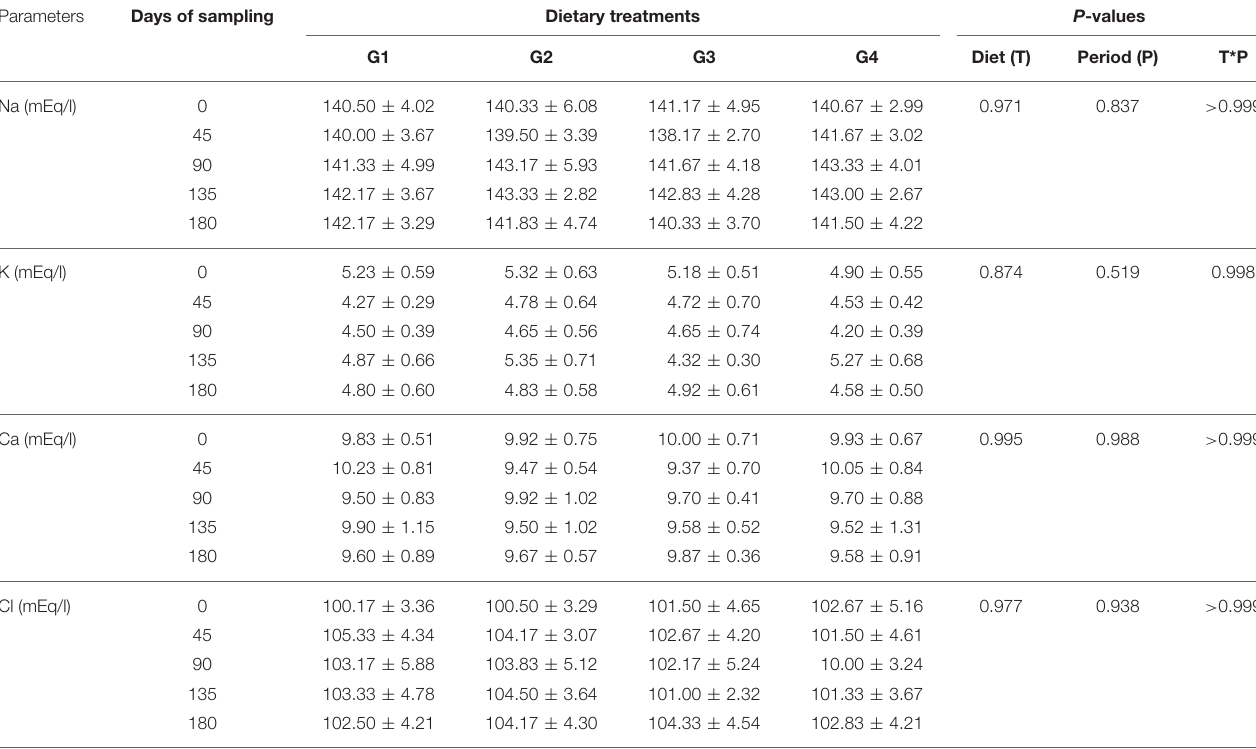
TABLE 6 | Effect of dietary Bt and CP4EPSPS proteins on the Serum electrolyte of female rabbits. Parameters Days of sampling Dietary